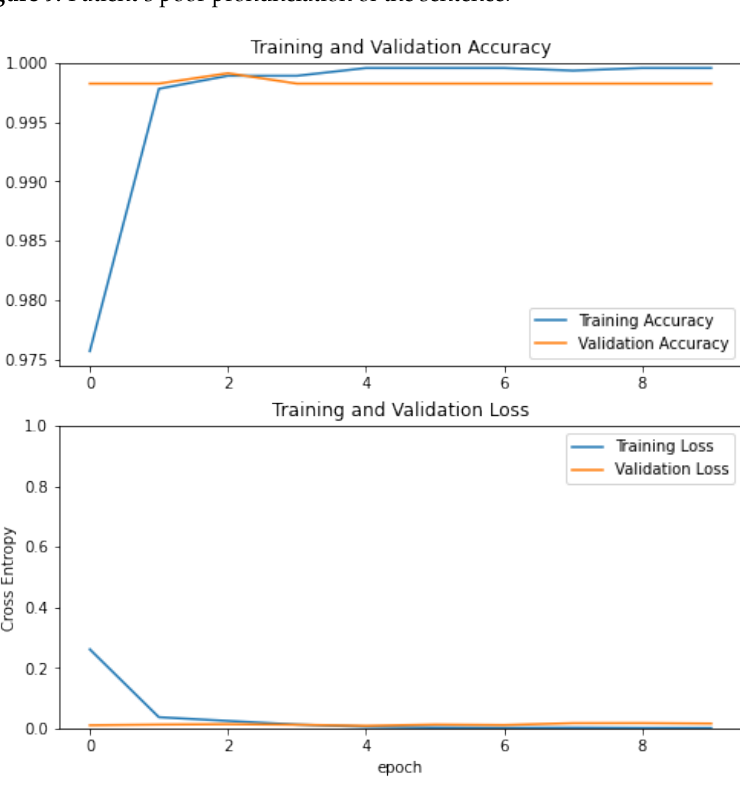
Figure 9. Patient’s poor pronunciation of the sentence.